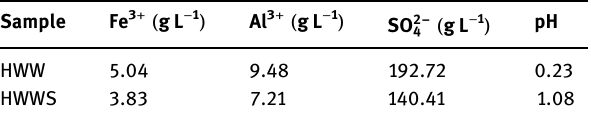
Table 1: Main components and pH value of HWW and